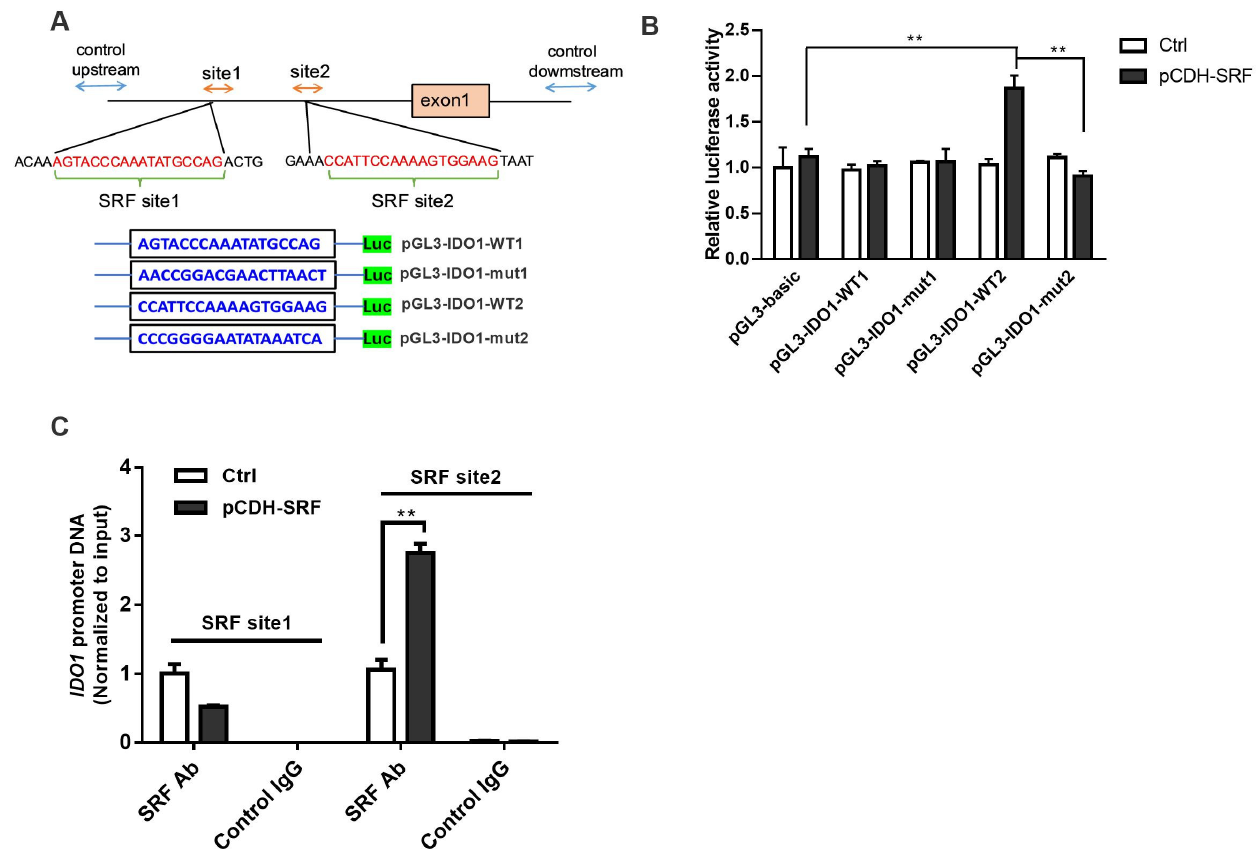
Figure 6. SRF is transcriptional factor that activates IDO1. ( A ) Promoter sequence of IDO1 and sequences of WT or mut binding sites. Predicted binding sites are marked in red. ( B ) Dual luciferase reporter assay on cells co-transfected with WT plasmids or plasmids with mut-binding sites and SRF cDNA. ( C ) SRF binding to the IDO1 promoter was detected using ChIP assays. ** p < 0.01 vs. control. ChIP, chromatin immunoprecipitation; IDO1, indoleamine 2,3-dioxygenase 1; mut, mutated; OSCC, oral squamous cell carcinoma; SRF, serum response factor; WT, wild-type.